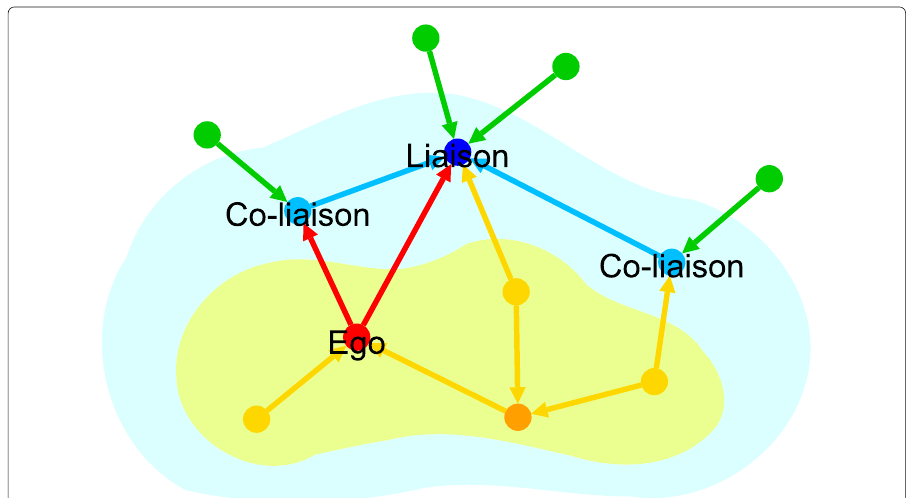
Fig. 4 Zone with eight nodes in four different roles. The zone has yellow inner-zone and blue outer-zone. Ego is dependent on Liaison and Co-liaison on the left, both Co-liaisons are dependent on Liaison, and other yellow nodes from inner-zone are dependent either on Ego or on Liaison or Co-liaison on the right. From a global perspective, the Liaison is a strongly-prominent node because it is not dependent on any other nodes and all its neighbors are one one-way dependent on it. The Ego, two Co-liaisons, and the dark yellow neighbor of Ego are weakly-prominent nodes; all of them have at least one neighbor dependent on them. Other nodes are